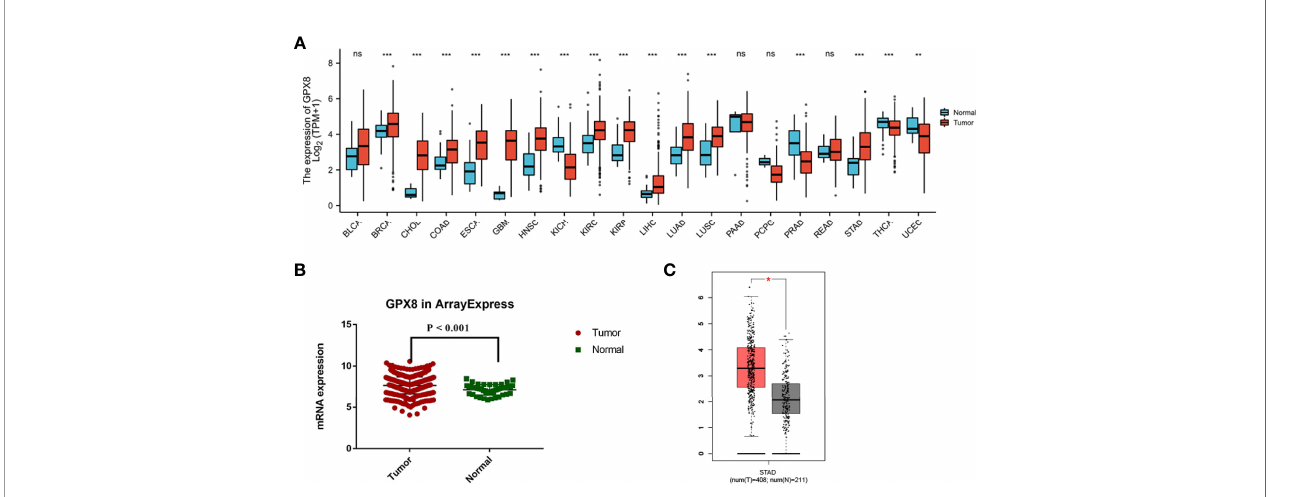
FIGURE 1 | Expression pattern of GPX8 in pan-cancer perspective and stomach adenocarcinoma and ROC curve. (A) Expression pattern of GPX8 in pan-cancer perspective (ns, P ≥ 0.05; *, P < 0.05; **, P < 0.01; ***, P < 0.001). (B) In TCGA database, the mRNA expression of GPX8 in ArrayExpress was signi fi cantly higher in stomach adenocarcinoma (red) than the adjacent normal tissue (green) (P<0.01). (C) Differential expression analysis of GPX8 between adjacent normal tissue (gray) and stomach adenocarcinoma (red) in the GEPIA